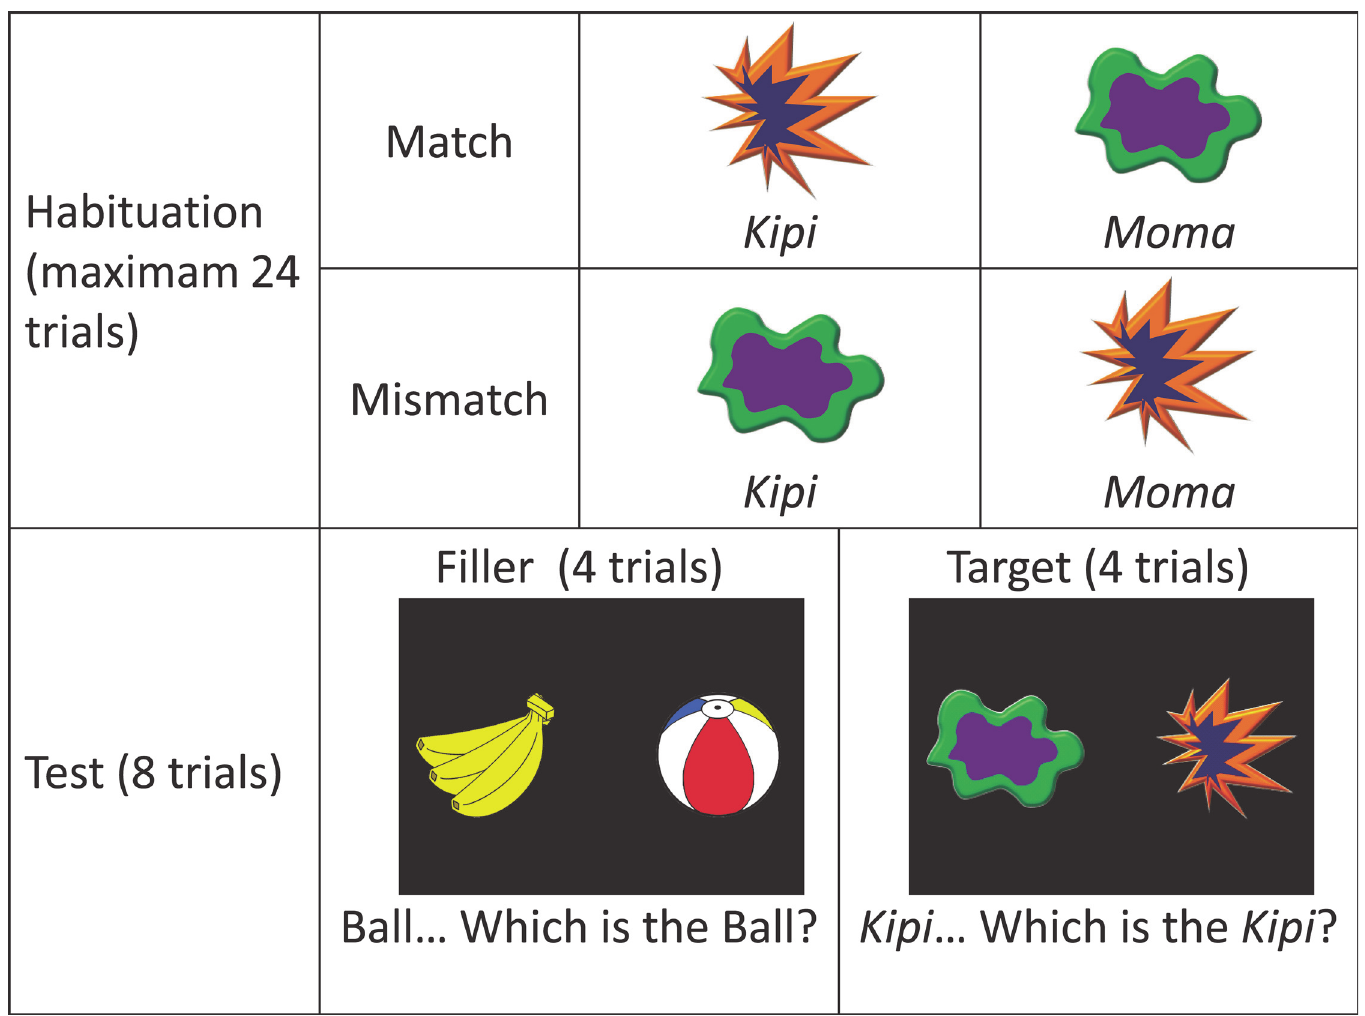
Fig 1. Design and